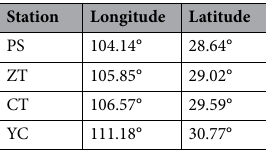
Table 6. Geographic location information of hydrological stations.